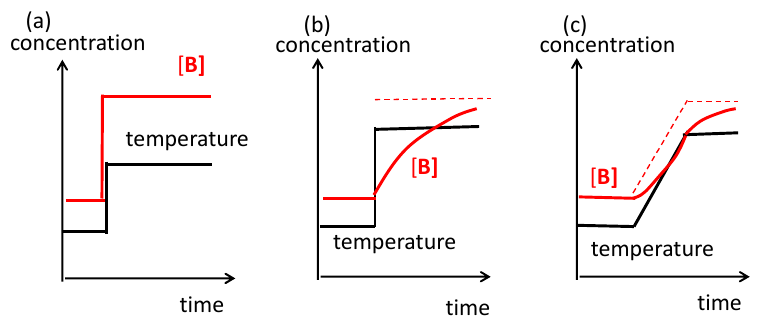
Figure 3. Thermal input and concentration output ( a ) under chemical equilibrium by a stepwise temperature change, ( b ) with delay-to-approach chemical equilibrium by a stepwise temperature change, and ( c ) with delay-to-approach chemical equilibrium by a gradual temperature change. Black lines show temperature changes; red lines show concentration changes; red dashed lines show concentration at chemical equilibrium.